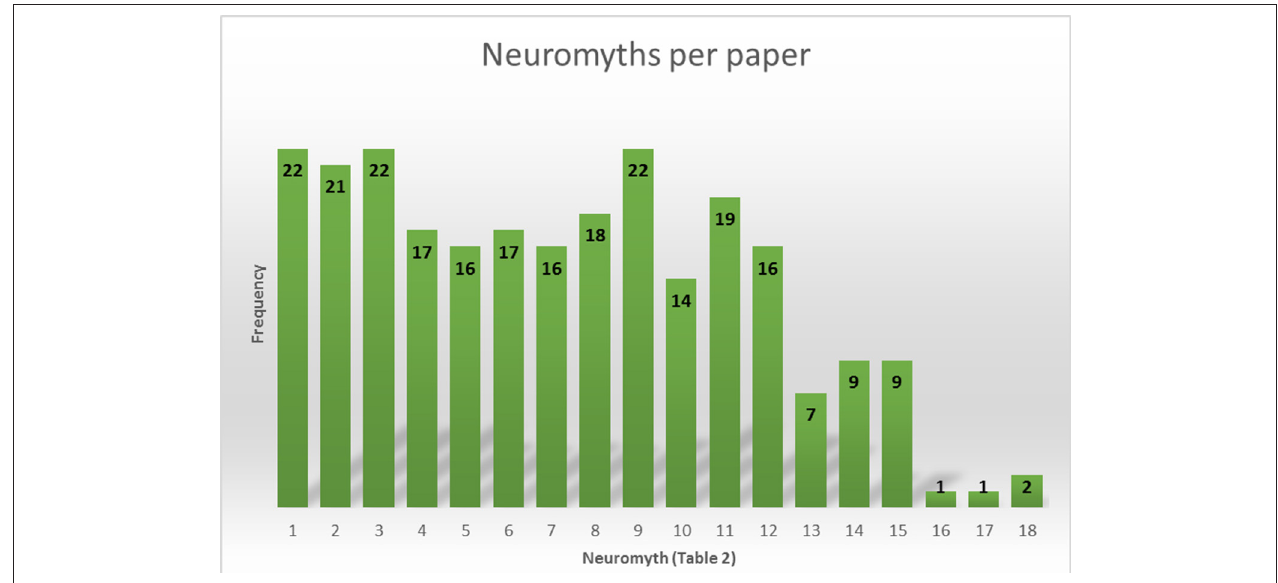
FIGURE 4 | Frequency of appearance of each neuromyth in the 24 articles.